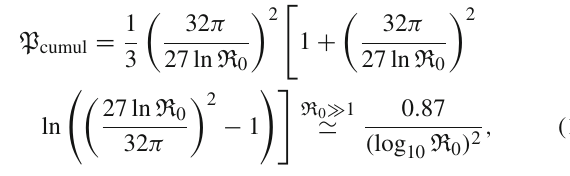
Fig. 3 Comparison of the cumulative probability (10) for the integra- tion of the whole L – H hypervolume in the decoupled and coupled scenarios (with g X = 0 . 2 and for different couplings ( Q L , Q H ) for each sector), both with λ LH =